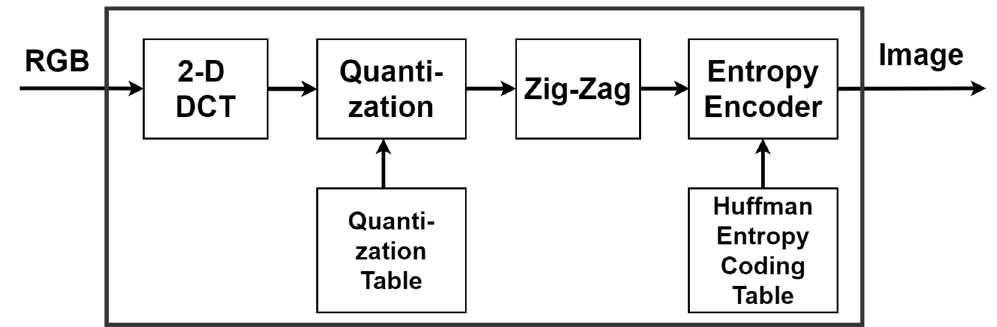
Figure 1. Flow chart of the standard image compression technique.